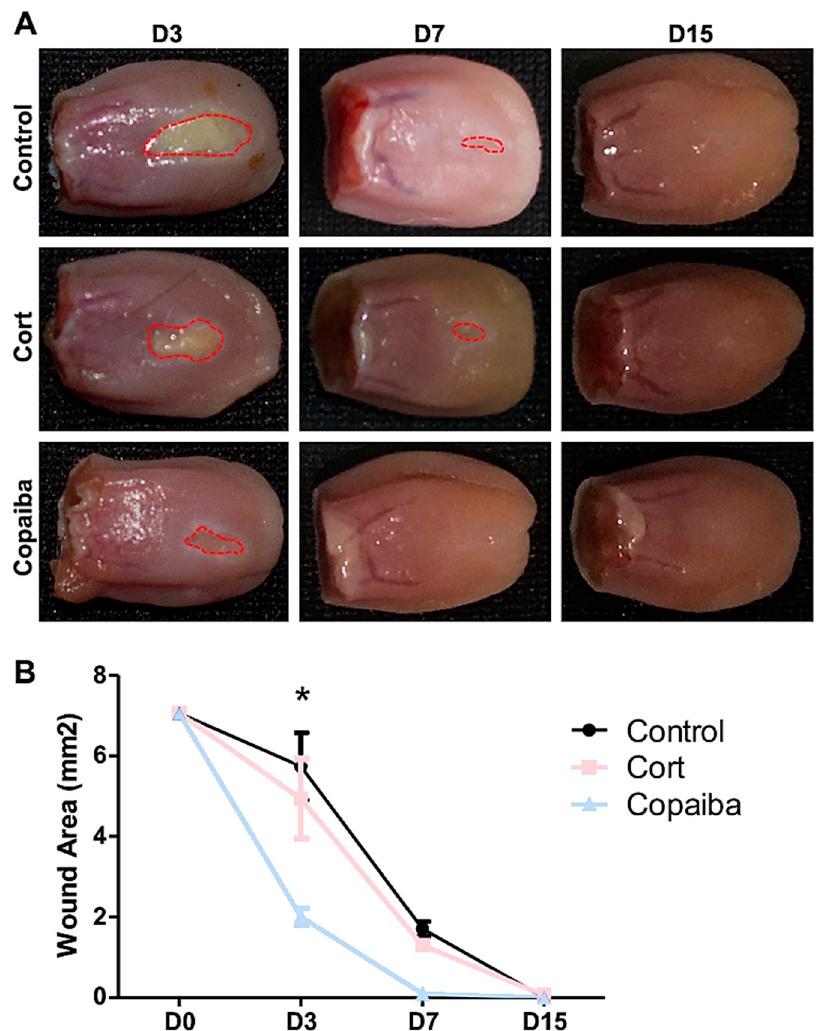
Figure 1. Clinical analysis of the wound area post-wounding. ( A ) Wounds post-treatment with copaiba oleoresin (200 mg / kg / day) and corticoid–dexamethasone (0.5 mg / kg / day), and untreated wounds. Copaiba-treated ulcers presented smaller wound area on D3 and completely disappeared in D7. Corticoid treatment promoted a reduction of the wound area on D3 compared to controls, but less e ff ective than the copaiba-treated group. ( B ) Graph comparing the contraction of the wounds throughout the time at D3 ( n = 15), D7 ( n = 15) and D15 ( n = 15) in untreated and treated groups. Two-way analysis of variance (ANOVA) followed by Tukey’s multiple comparison tests (* p < 0.05).